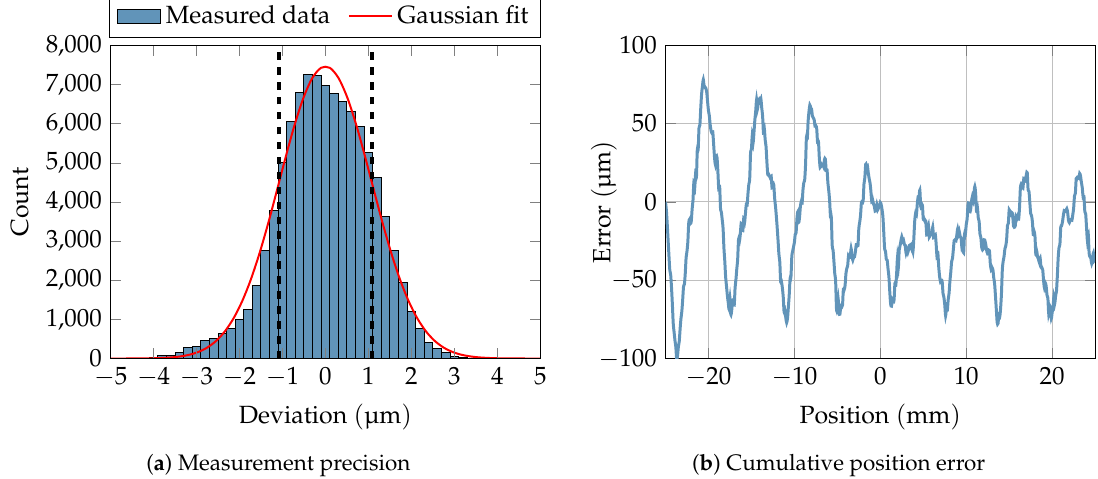
Figure 10. Measurement of precision and cumulative distance error of the presented radar